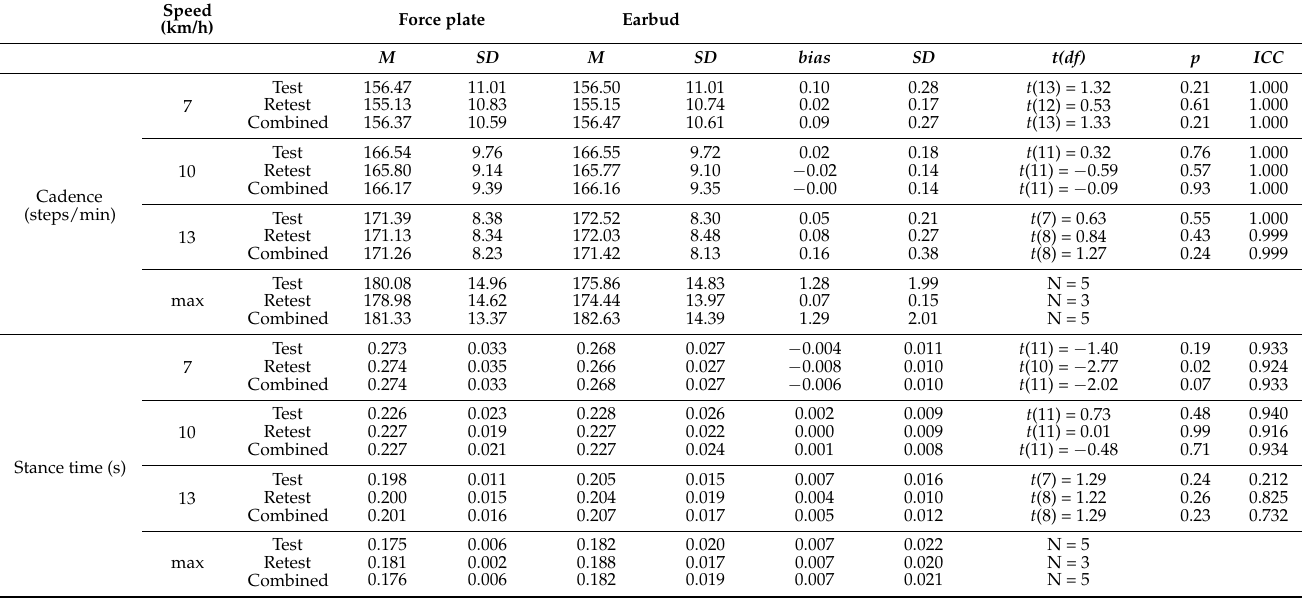
Table 3. Between-methods bias and agreement of cadence and stance time between earbud and force-plate methods for the speed conditions (bias = earbud − force plate).